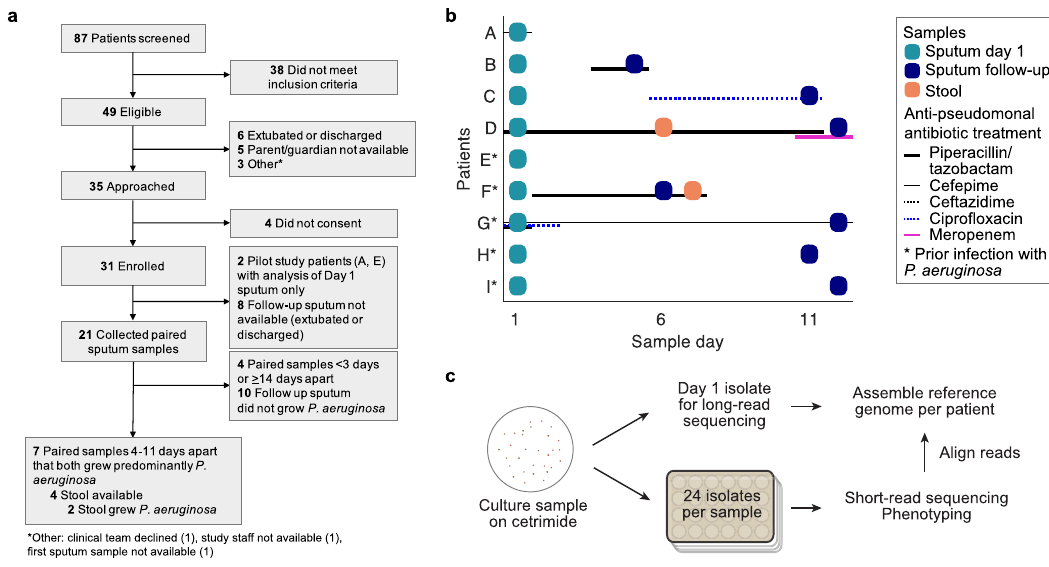
Fig. 1 Prospective study of P. aeruginosa populations from mechanically ventilated patients during acute respiratory tract infection. a Prospective study design describing the enrollment strategy of mechanically ventilated patients in the ICU. Of 87 patients screened, 49 eligible patients were identi fi ed, from which 31 consented to enrollment. We focused on 2 pilot patients sampled at only day 1, and 7 patients sampled serially across 4 – 11 days that exhibited predominant P. aeruginosa growth in both samples. b Sampling sputum and stool across patients ( y -axis) over time ( x -axis) from the onset of symptoms. Day 1 sputum sample (teal box) were collected in all patients, and a follow-up sputum (dark blue box) were collected in 7 patients between day 5 and day 12, i.e. 4 – 11 days after day 1. Stool samples (brown box) with con fi rmed P. aeruginosa growth were collected in 2 patients. Asterisk: patients with prior P. aeruginosa infection. Treatment with anti-pseudomonal antibiotics are indicated by horizontal lines: piperacillin/tazobactam (weighted black), cefepime (thin black), ceftazidime (dotted black), cipro fl oxacin (dotted blue), meropenem (weighted pink). c Samples (sputum or stool) were cultured on cetrimide agar in serial dilutions. A single isolate from day 1 sputum of each patient was used to construct a patient-speci fi c reference genome using long-read sequencing. From each sample, 24 isolates were randomly selected for short-read whole-genome sequencing and